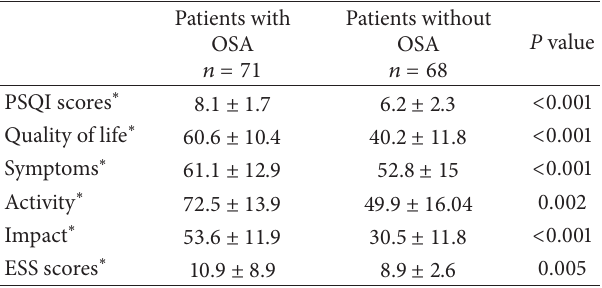
Table 2: Sleep quality, quality of life, and sleepiness in studied patients with or without obstructive sleep apnea (OSA).